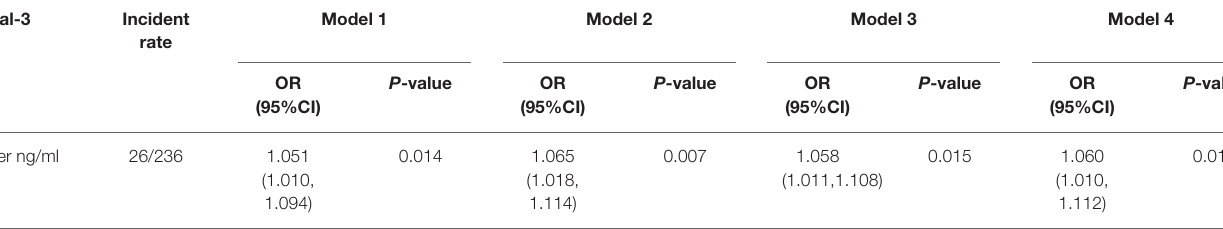
TABLE 7 | Association between serum Gal-3 and incident rate of